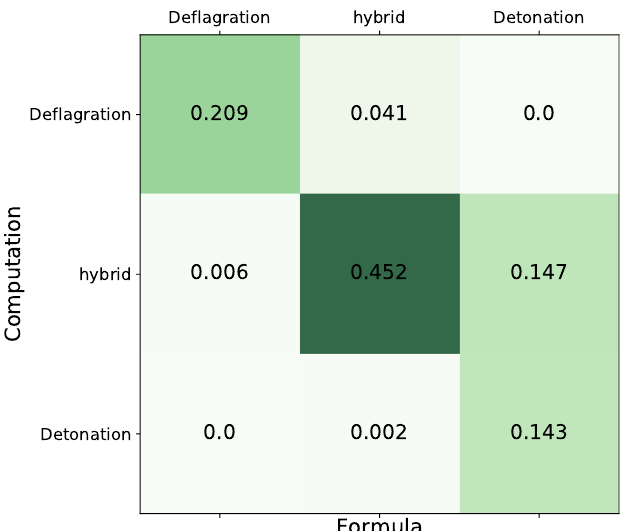
Figure 5 . The confusion matrix for multi-class classification of the hydrodynamic expansion based on the computation of the wall velocity [127]. The rows (columns) denote the fraction of points that fall within each class as obtained from a full numerical computation (analytic